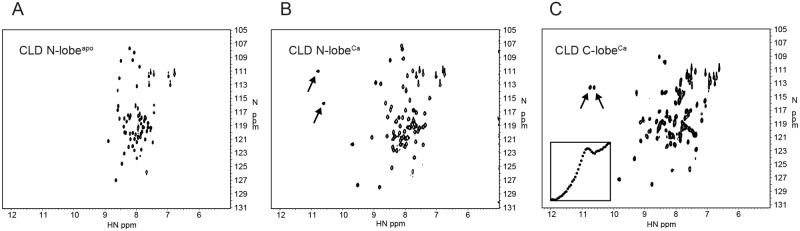
15N-HSQC spectra for (A) CLD N-lobeapo, (B) CLD N-lobeCa and (C) CLD C-lobeCa.The inset in panel C shows a circular dichroism thermal denaturation profile for CLD C-lobeCa in the temperature range 16–94°C.